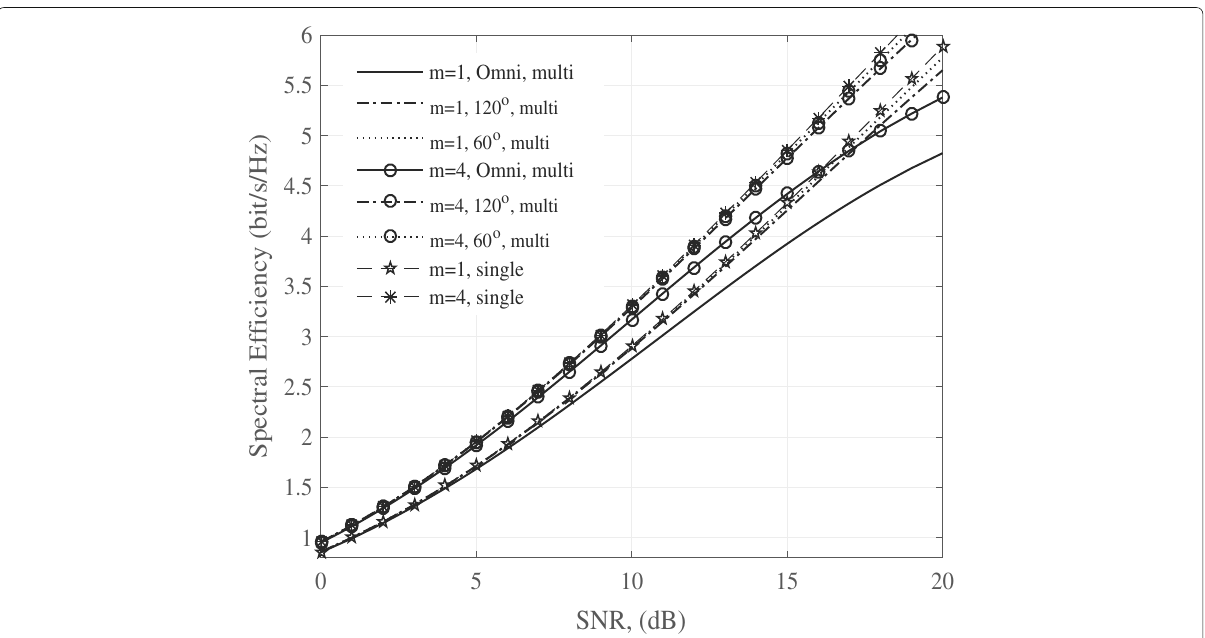
Fig. 4 Spectral efficiency in (bit/s/Hz) for single- and multi-cell cellular networks for three different antenna configurations as a function of SNR for various values of fading figure, m , with R d = 3.5 and α = 4. SE of multi-cell network with omni antenna system for m = 1 and 4, SE of multi-cell network with 120 ◦ sectorized antenna system for m = 1 and 4, SE of multi-cell network with 60 ◦ sectorized antenna system for m = 1 and 4, SE of single-cell network for m = 1 and 4